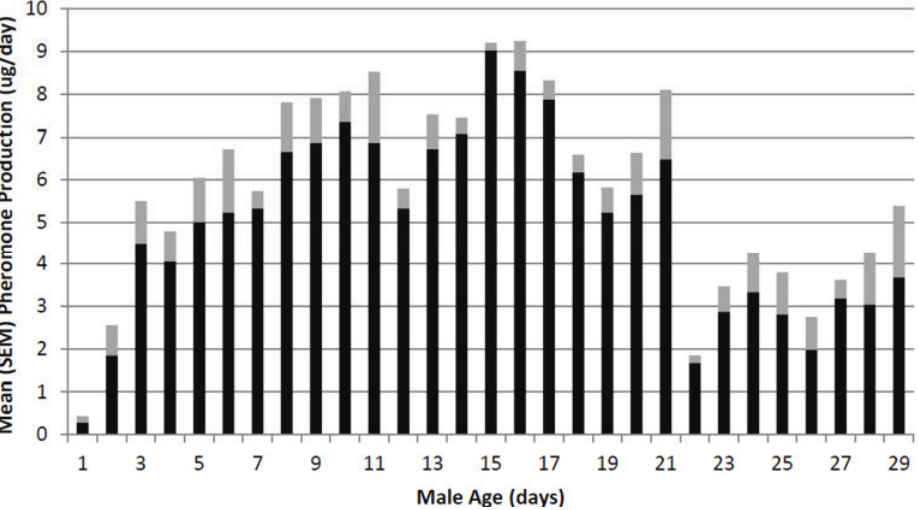
Figure 1. Effect of male pepper weevil age on pheromone production. Values represent means (black bar) and standard deviation of the mean (SEM) (gray